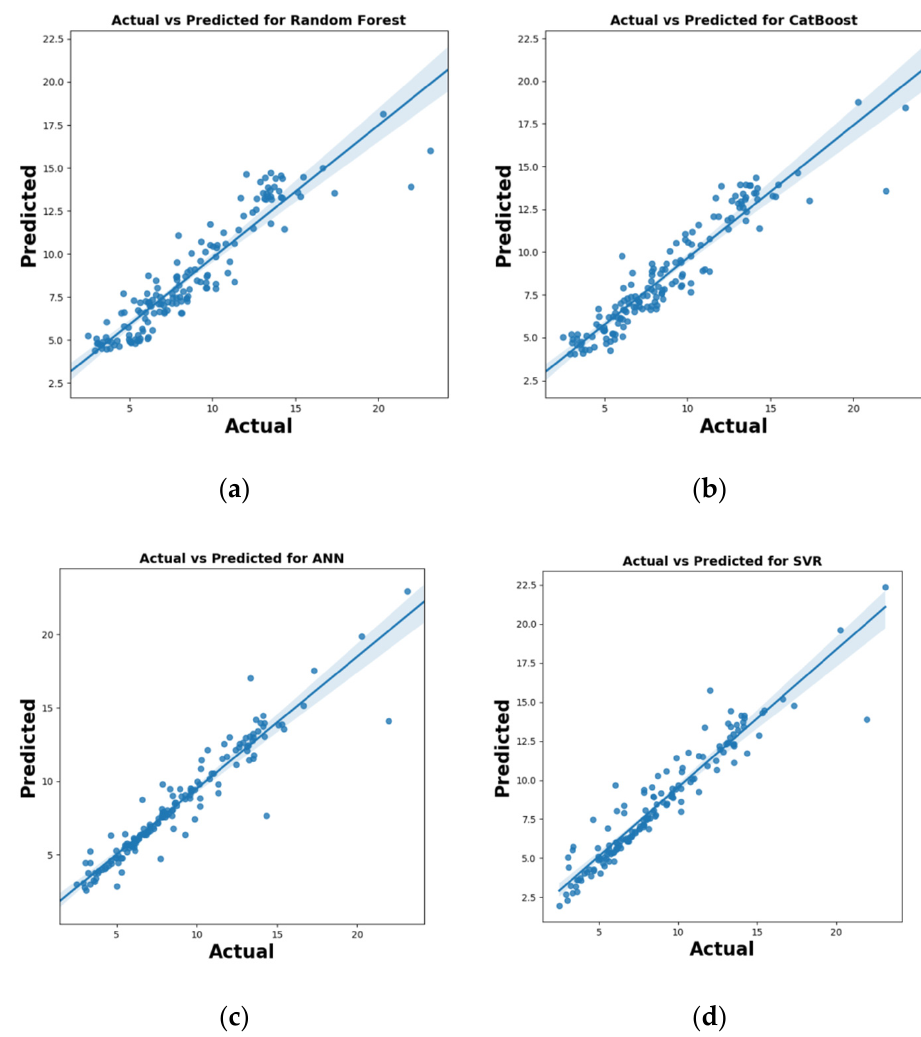
Figure 8. Comparison of Average seepage (Actual vs. Predicted) for ( a ) RF, ( b ) CatBoost, ( c ) ANN and ( d ) SVM Models.